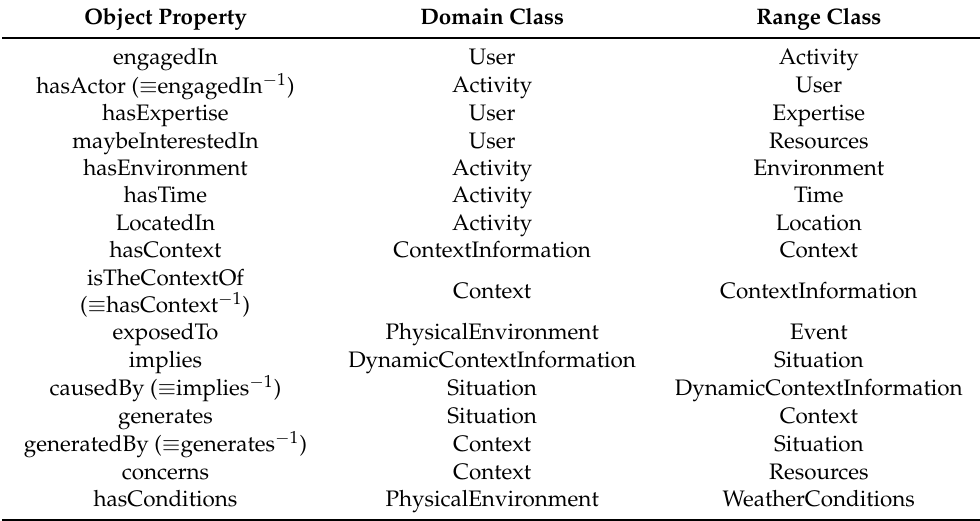
Table 4. Object properties between main